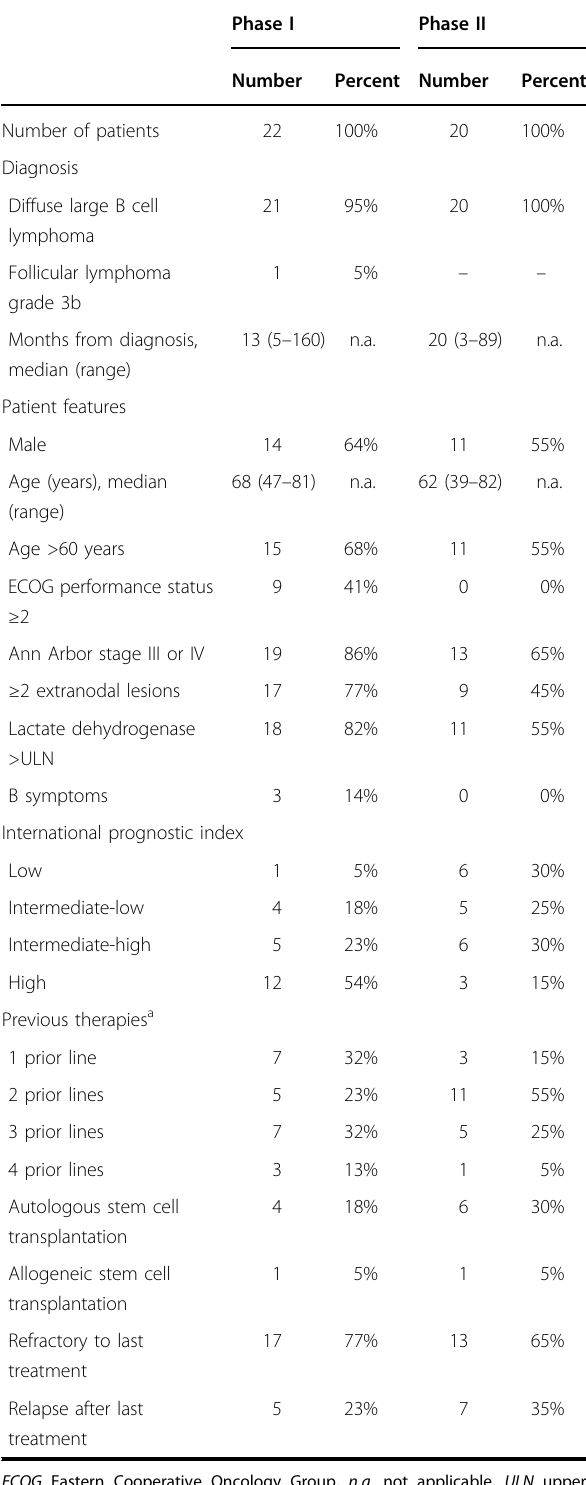
Table 1 Patient